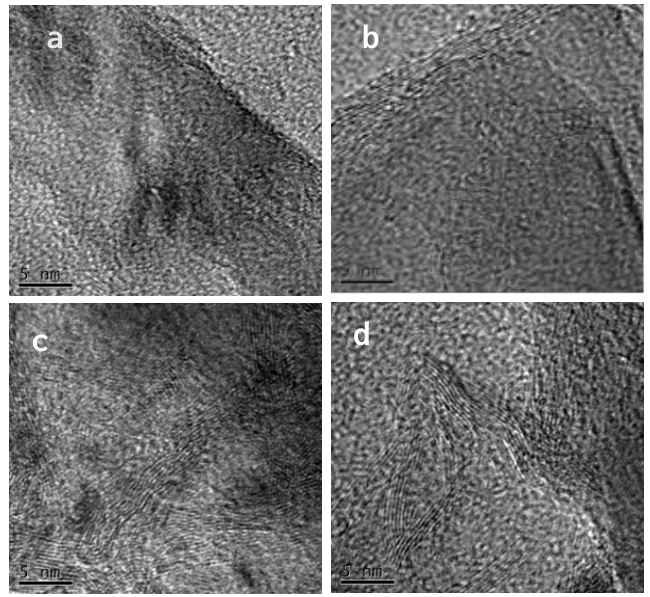
Figure 1. The TEM images of ND catalysts treated at different temperatures for ND500 ( a ), ND700 ( b ), ND900 ( c ), and ND1100 ( d ).